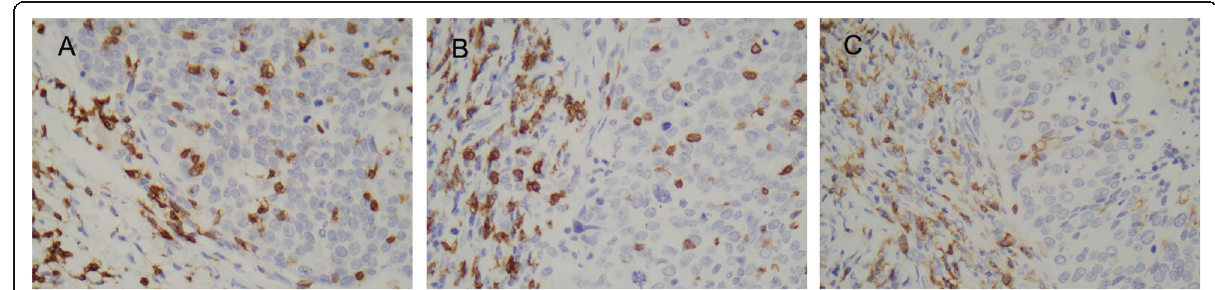
Fig. 3 Immunohistochemical staining for TILs. CD3(A), CD8(B), and CD4(C) were present in both tumor area and surrounding peritumoral